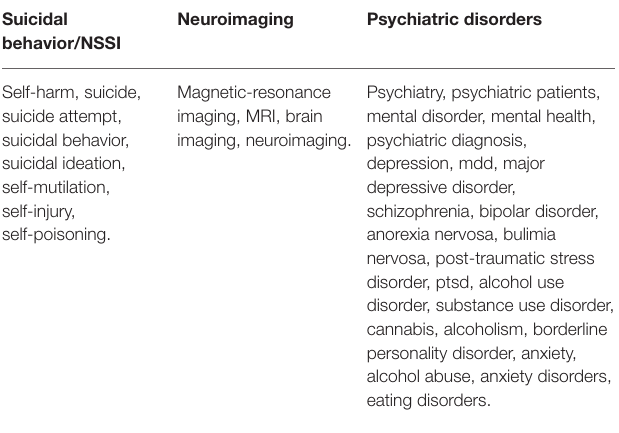
TABLE 1 | Keywords used to query the bibliographic databases.